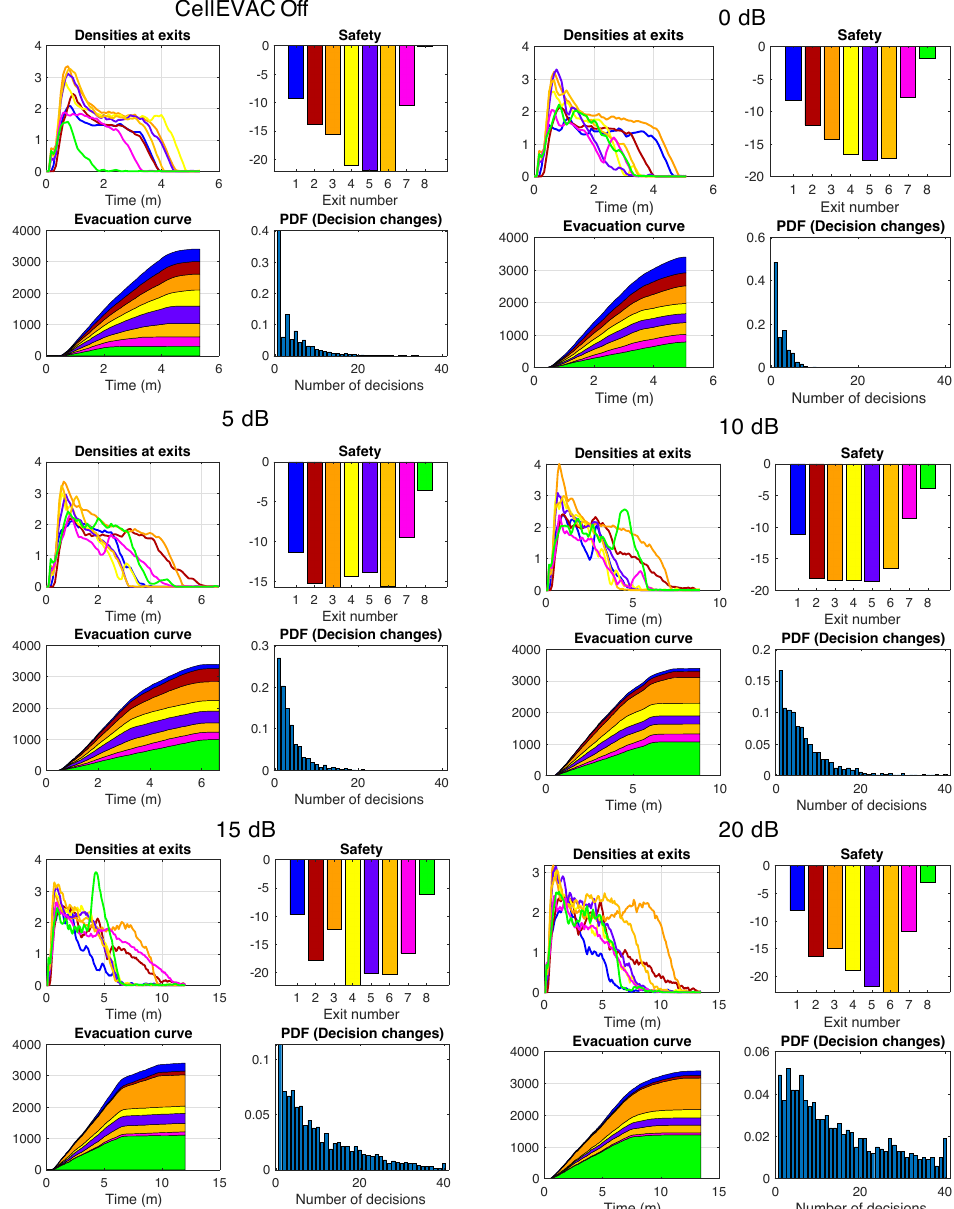
Figure 8. Results of single run simulations without external flows in evacuation scenarios in which pedestrians do not use CellEVAC (CellEVAC Off), and in evacuation scenarios using CellEVAC and assuming positioning errors from 0 to 20 dB. Each subfigure shows the evolution of density, safety values and evacuation curves at each exit gate, and the histogram (probability density function) of the number of decision changes of the pedestrians. Colors identify the different exit gates, as described in the Madrid Arena